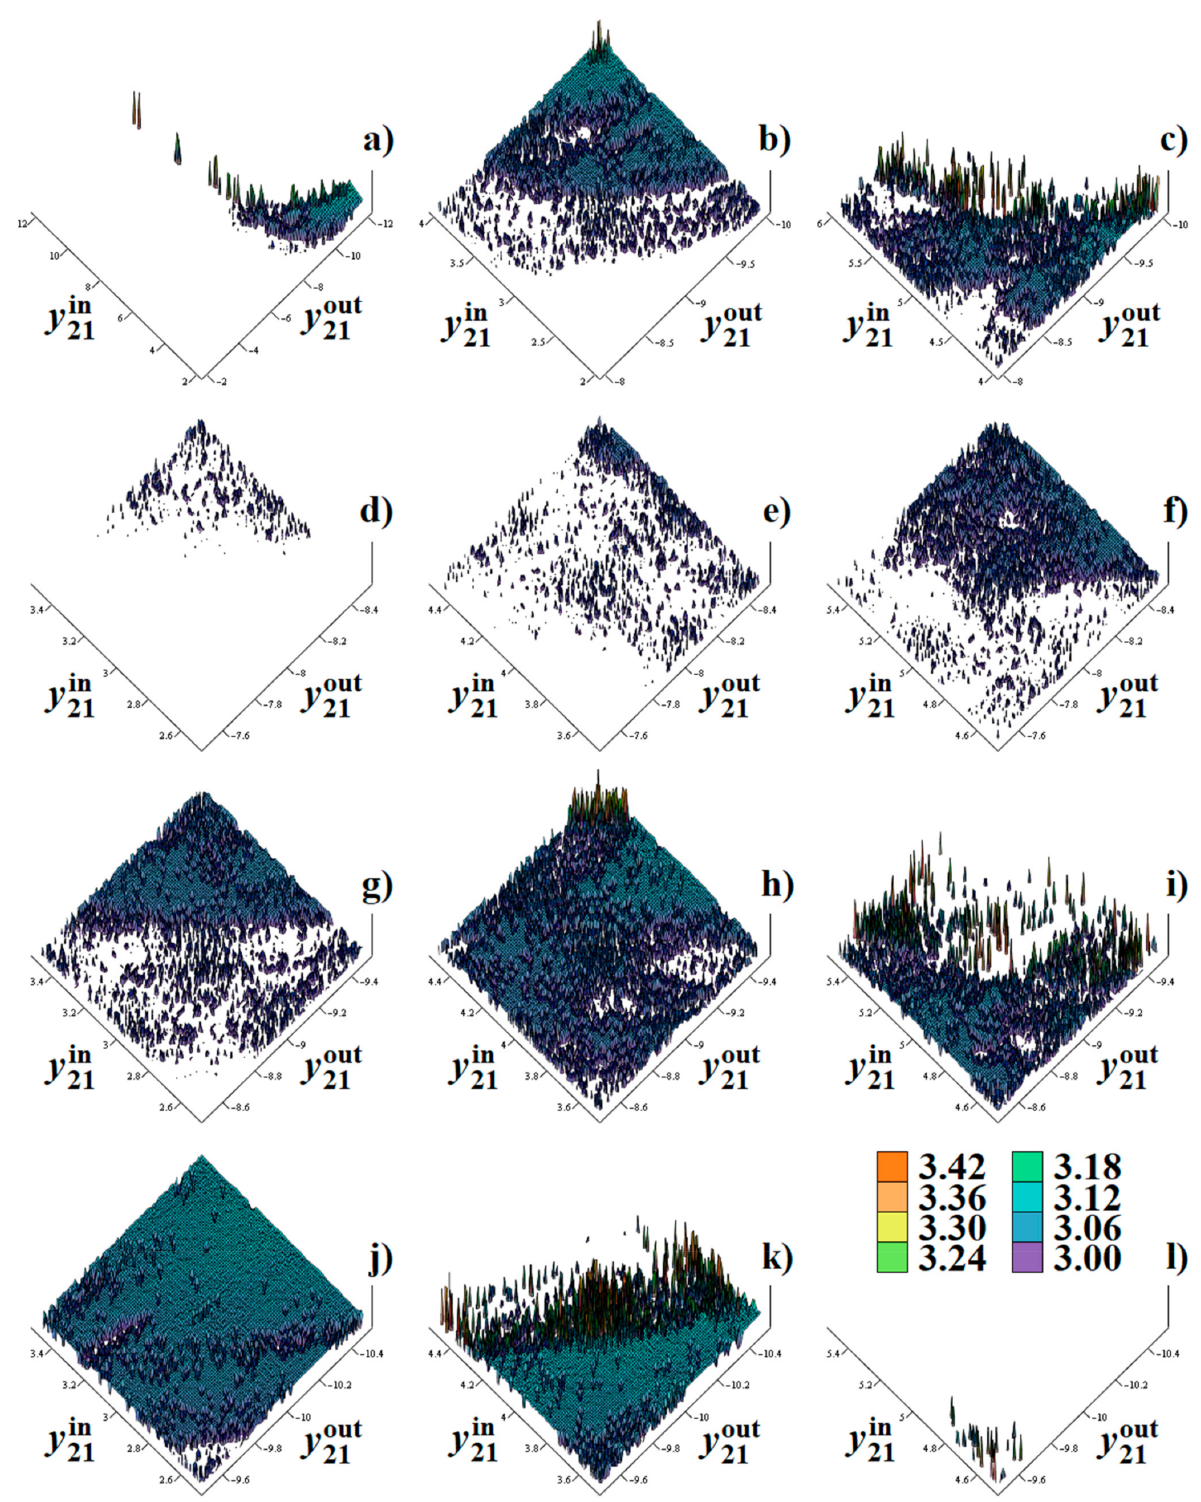
Figure 8. Clapp oscillator, Case II, rainbow-scaled surface plot of the KYD of hyperchaotic motion as function of PWL function shaping coefficients: ( a ) general view, ( b , c ) follow-up zoomed areas. Squared regions of parameters investigated in more details, with the slopes in both outer segments: ( d – f ) y 21 out ∈ ( − 8.5, − 7.5) S, ( g – i ) y 21 out ∈ ( − 9.5, − 8.5) S, and ( j – l ) y 21 out ∈ ( − 10.5, − 9.5) S. Figure contains the colored legend that apply to all